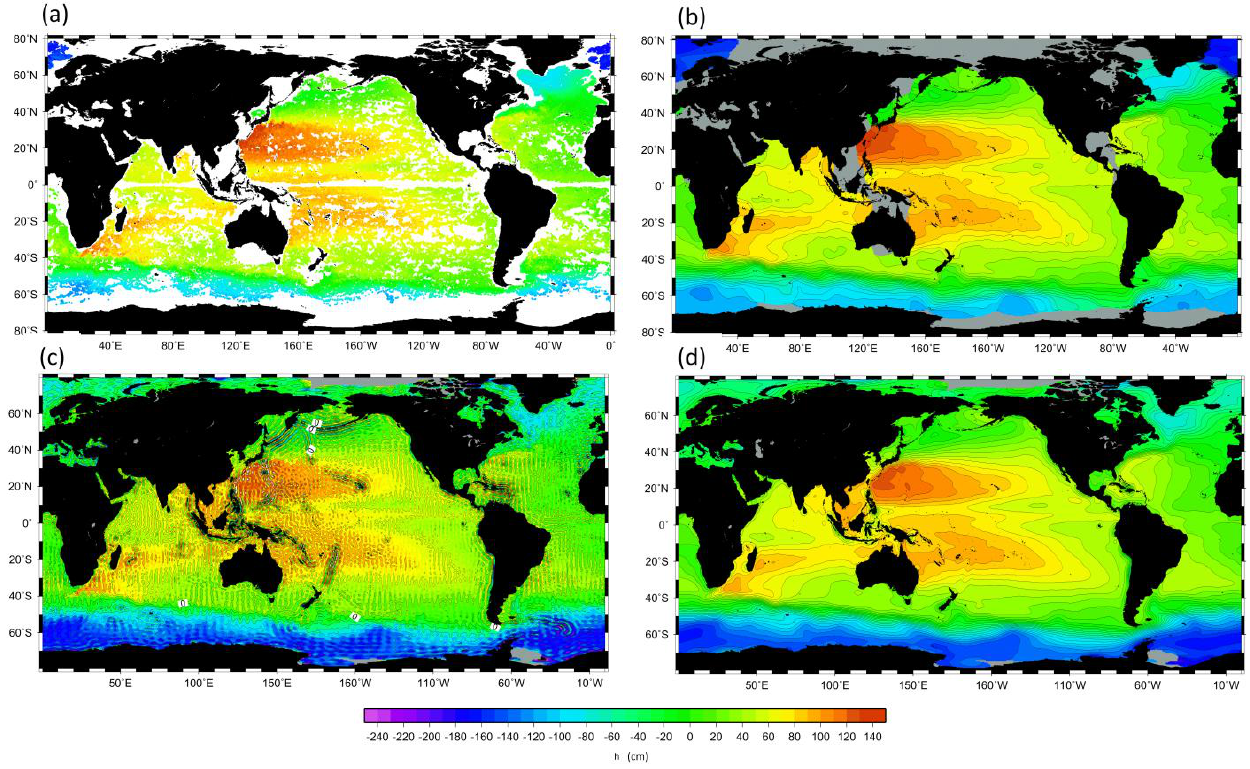
Figure 2: Synthetic estimates of the MDT unfiltered (a) and filtered at 500km (b). Direct MDT computed from MSS CLS01 Fig. 2. Synthetic estimates of the MDT unfiltered (a) and filtered at 500km (b) . Direct MDT computed from MSS CLS01 and EIGEN-GL05S filtered at 133km (c) and filtered at 500km (d) and EIGEN-GL05S filtered at 133 km (c) and filtered at 500km (d).